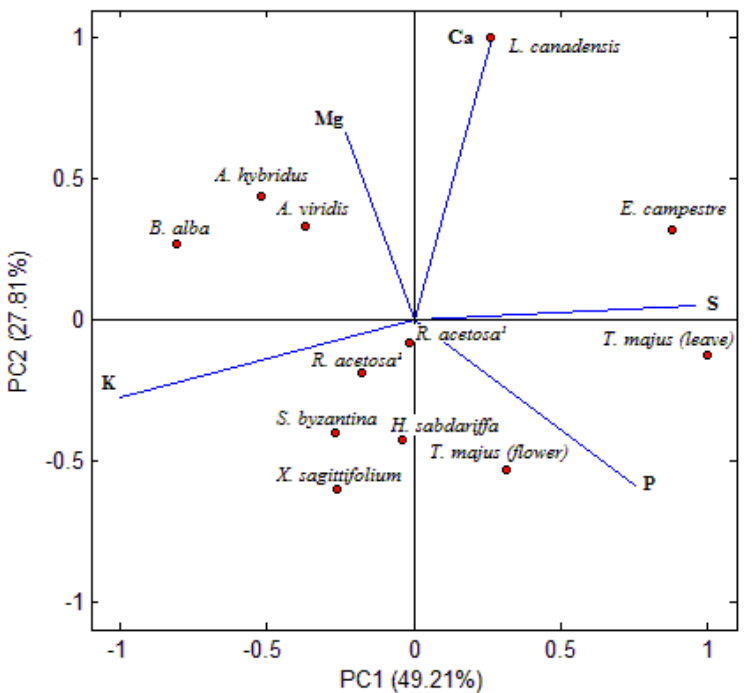
Figure 3 - Analysis of the main components related to the observed results for the levels of macronutrients P, K, Ca, S and